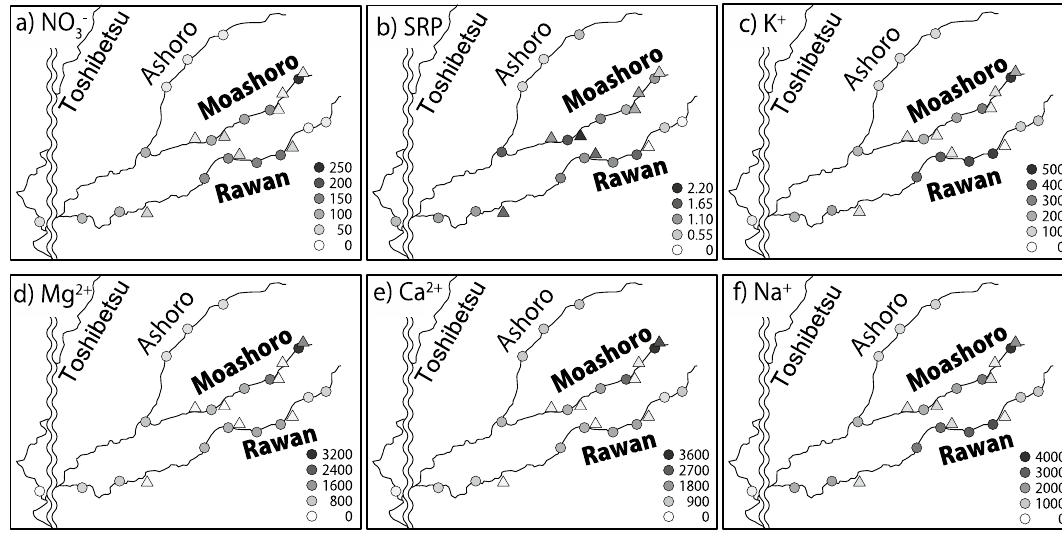
Figure 1. Spatial variations in concentrations of ( a ) NO 3 − , ( b ) soluble reactive phosphorus (SRP), ( c ) K + , ( d